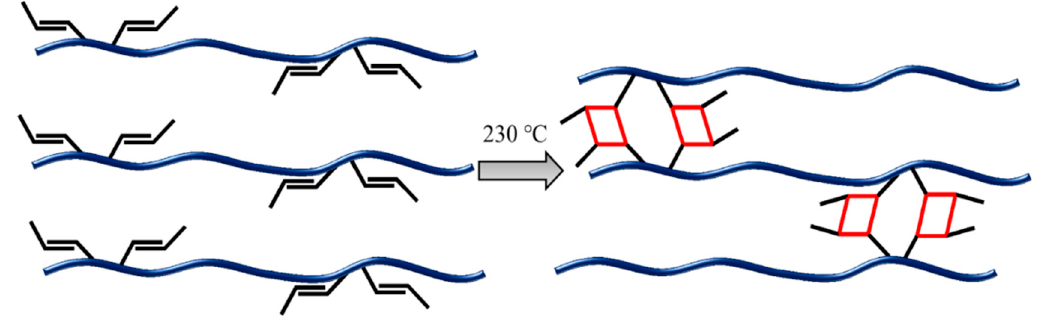
Figure 2. Schematic of the crosslinked polymer chains of sulfonated poly (aryl ether nitrile).